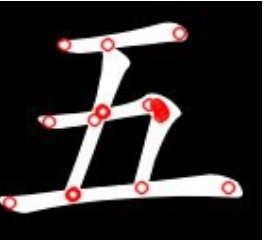
Figure 4. Feature points found by neighborhood